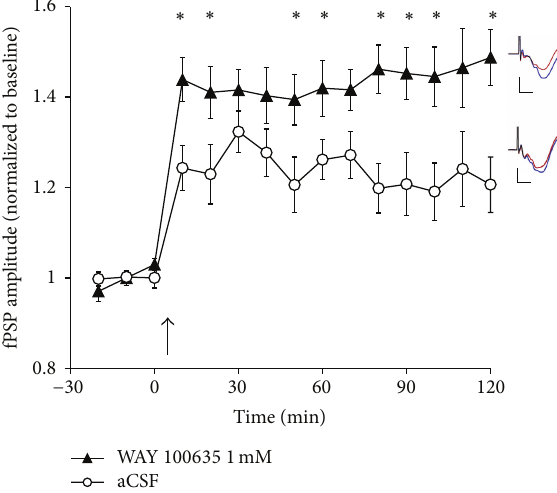
Figure 4: The effect of application (in V1 by means of reverse microdialysis) of either aCSF/vehicle ( 𝑛 = 11 ; see text for detail regarding this control group) or methiothepin (1mM, 𝑛 = 13 ) on LTP following TBS (at arrow) of the LGN in urethane-anesthetized rats. Application of methiothepin resulted in a significant increase in LTP relative to control animals. Inserts depict typical fPSPs before (red) and after (blue) LTP induction in the presence of methiothepin (top) and control animals (bottom; calibration bars indicate 0.5 mV vertical and 10ms horizontal; each fPSP trace is an average of 30 min of continuous recording). ∗ indicates a significant ( 𝑃 < 0.05 , 𝑡 -test) difference between the two groups.